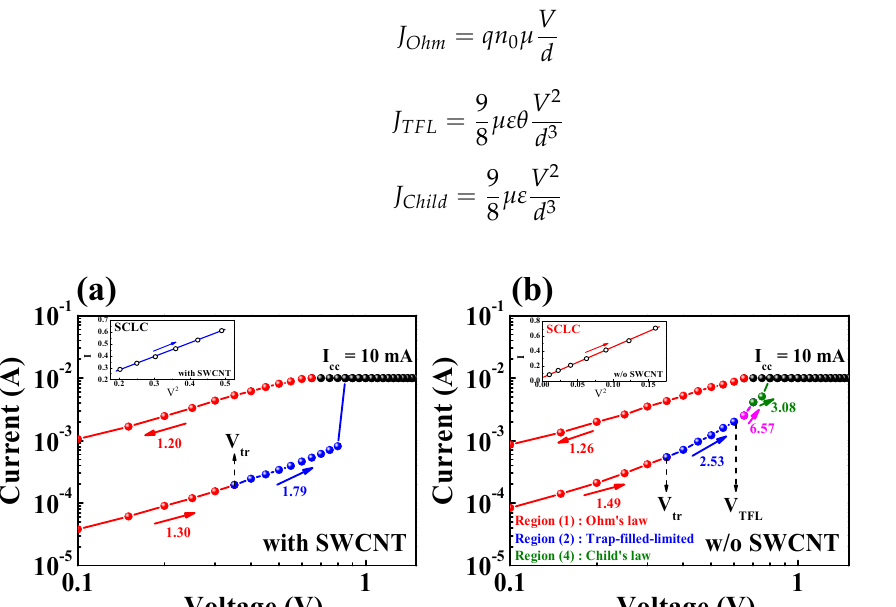
Figure 5. SCLC mechanism shown via double-logarithmic I–V curves of the chitosan nanocomposite memristors ( a ) with and ( b ) without SWCNTs. The HRS I–V curves at a high voltage are shown in the insets, which are well fitted by the SCLC mechanism.